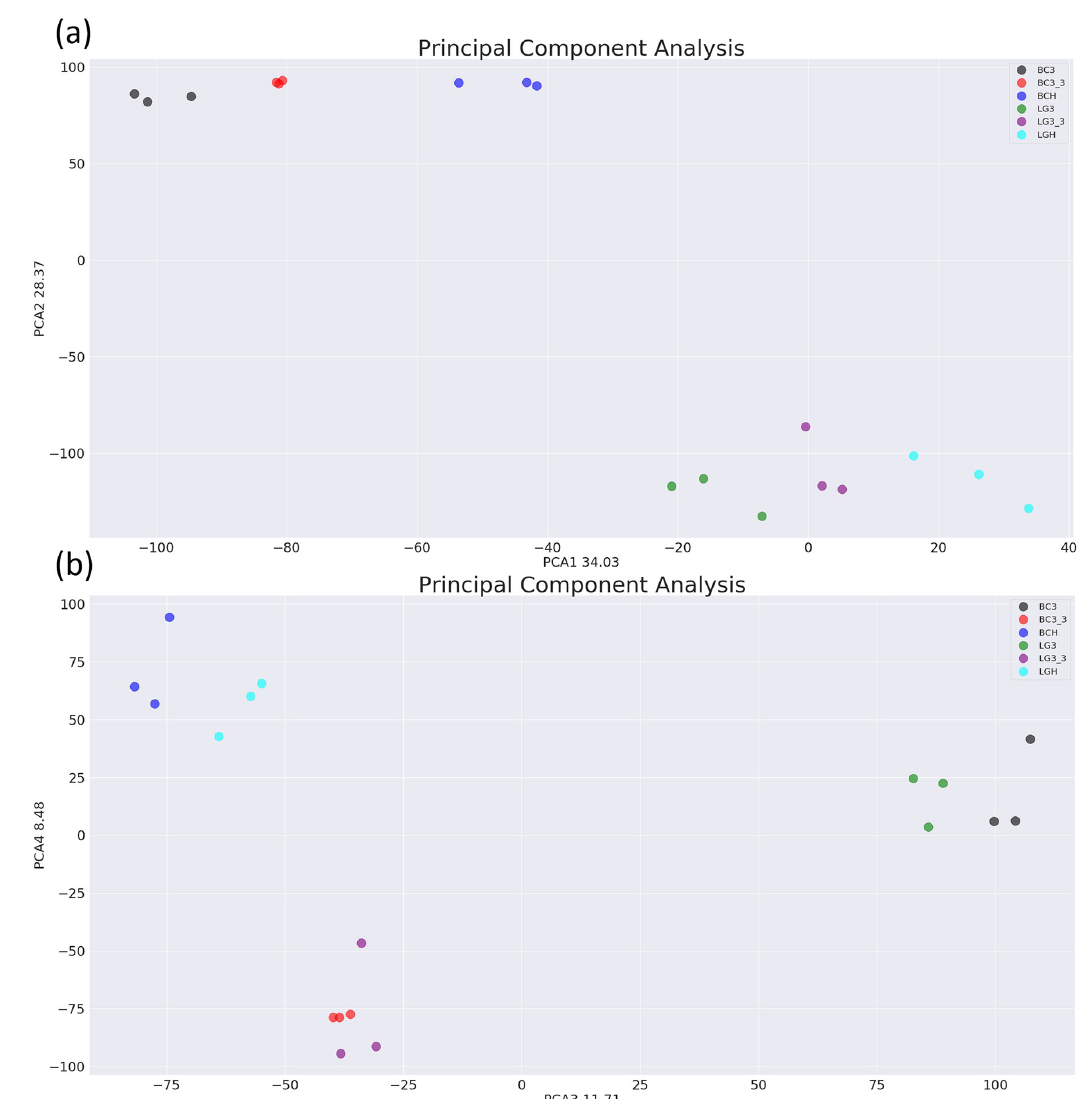
Fig 1. Principal component analysis showing (a) PCA1 and PCA2 (b) PCA3 and PCA4 for ‘Bluecrop’ and ‘Legacy’ fruit at harvest (BCH and LGH), 21 days post-harvest (dph) at 4˚C (BC3 and LG3) and 21 dph at 4˚C followed by 3 dph at 18˚C (24 dph) (BC3_3 and